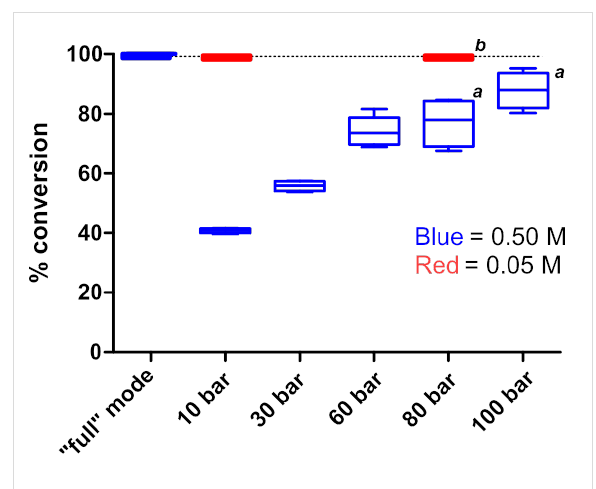
Figure 3: Box plot of data showing the percent conversion of styrene to ethylbenzene as a function of pressure. All reactions were performed using a 10% Pd/C 30 mm CatCart ® , MeOH, flow rate 1.0 mL/min, at 30 °C, with 1.9 mL per injection and 10 mL product solution collected. The conversion was determined by GC–MS analysis with decane as an internal standard; n = 5 unless otherwise indicated. Data represented in blue correspond to 0.50 M styrene in MeOH. Data represented in red correspond to 0.050 M styrene in MeOH. a n = 4. b n =